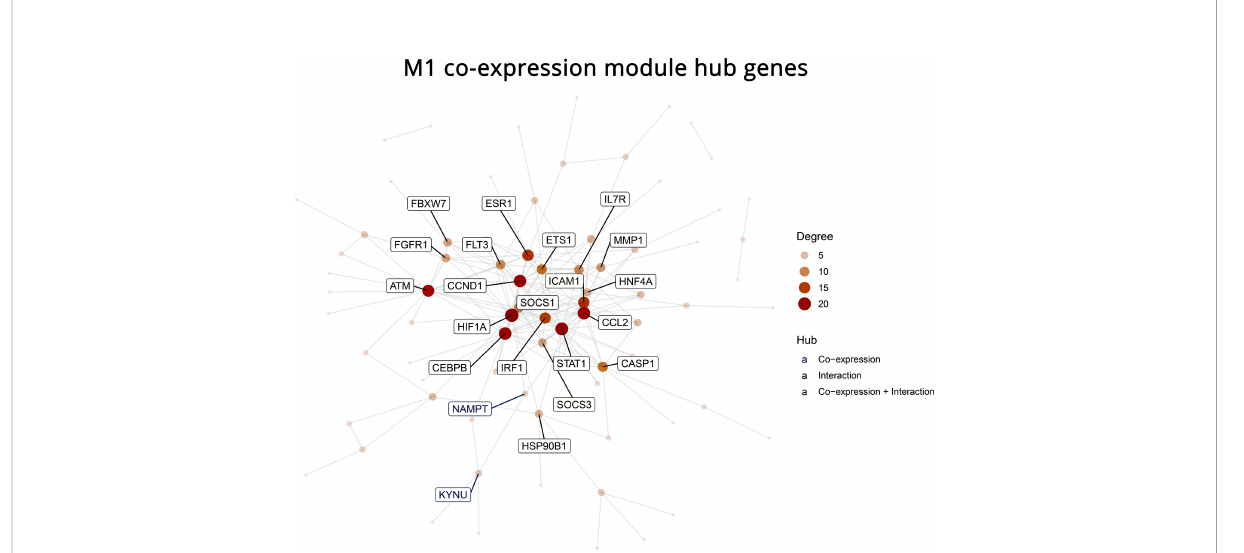
FIGURE 5 Protein-Protein Interaction (PPI) network of the 112 genes in the co-expression module M1. Twenty-one hub genes are labeled. The PPI was built with the STRING database based on known interactions between the provided genes. Hubs were de fi ned as genes with a high degree centrality score, which signi fi es higher interconnectivity with other genes and importance for the stability of the